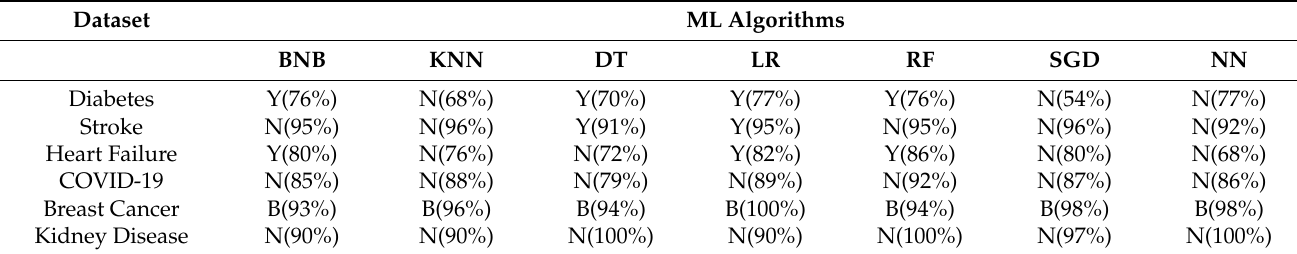
Table 15. Prediction results and accuracy per ML model for each use